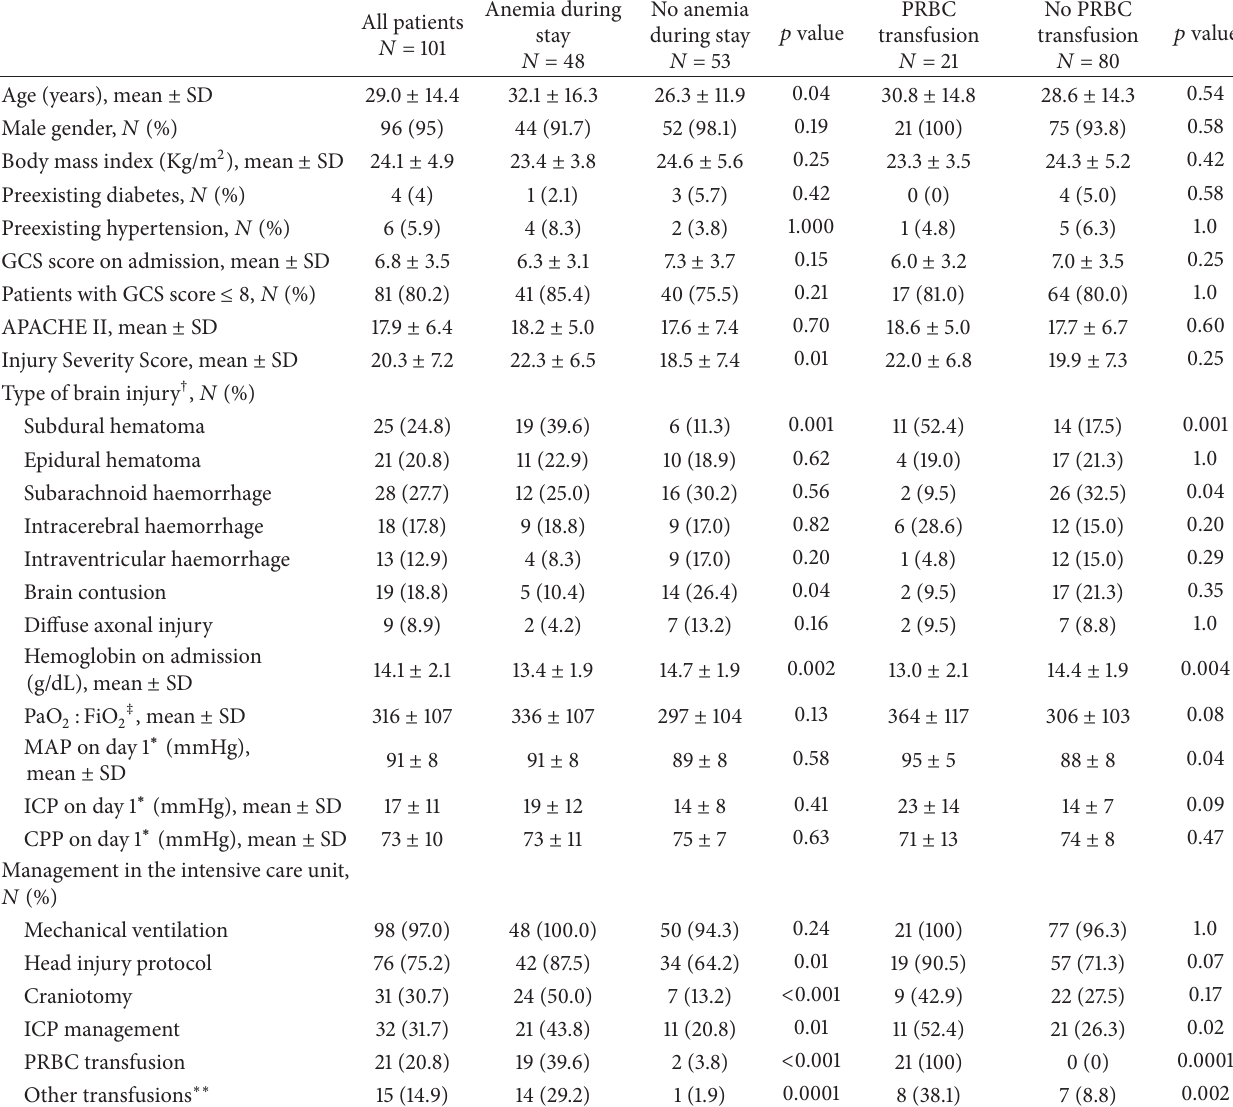
Table 1: Characteristics of patients according to the occurrence of anemia (nadir hemoglobin less than 10 g/dL) during stay in the intensive care unit and packed red blood cell transfusion